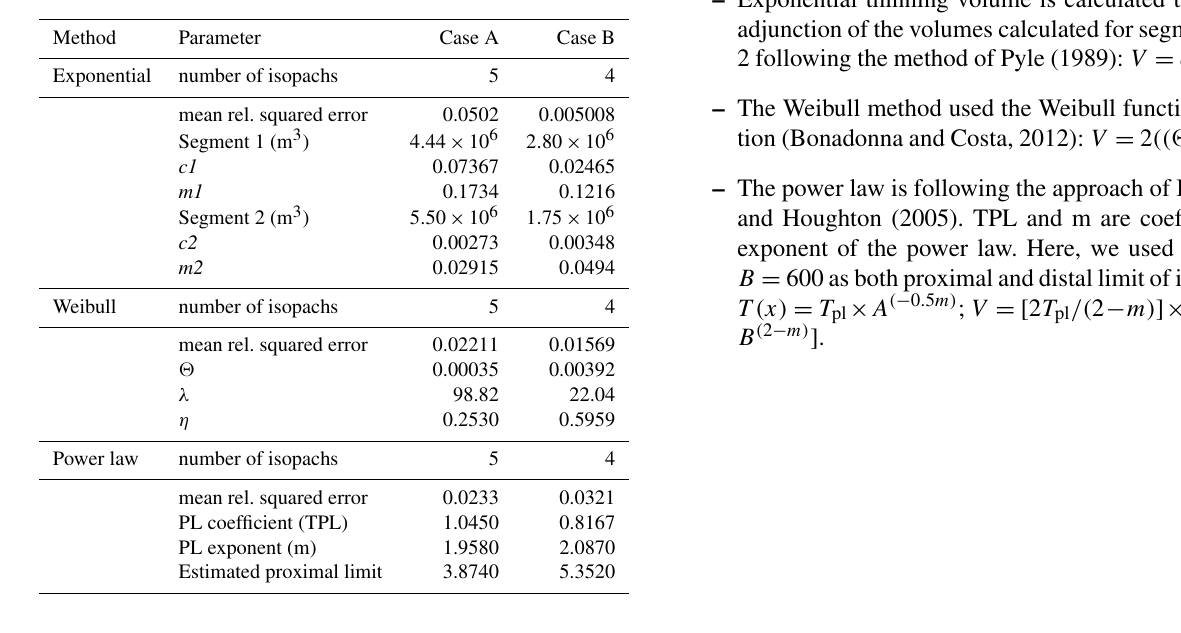
Table A2. Volume and mass calculation for the tephra fall deposit. Italics correspond to numerical parameters needed for volume esti- mates using the different methods. See Appendix B for details.